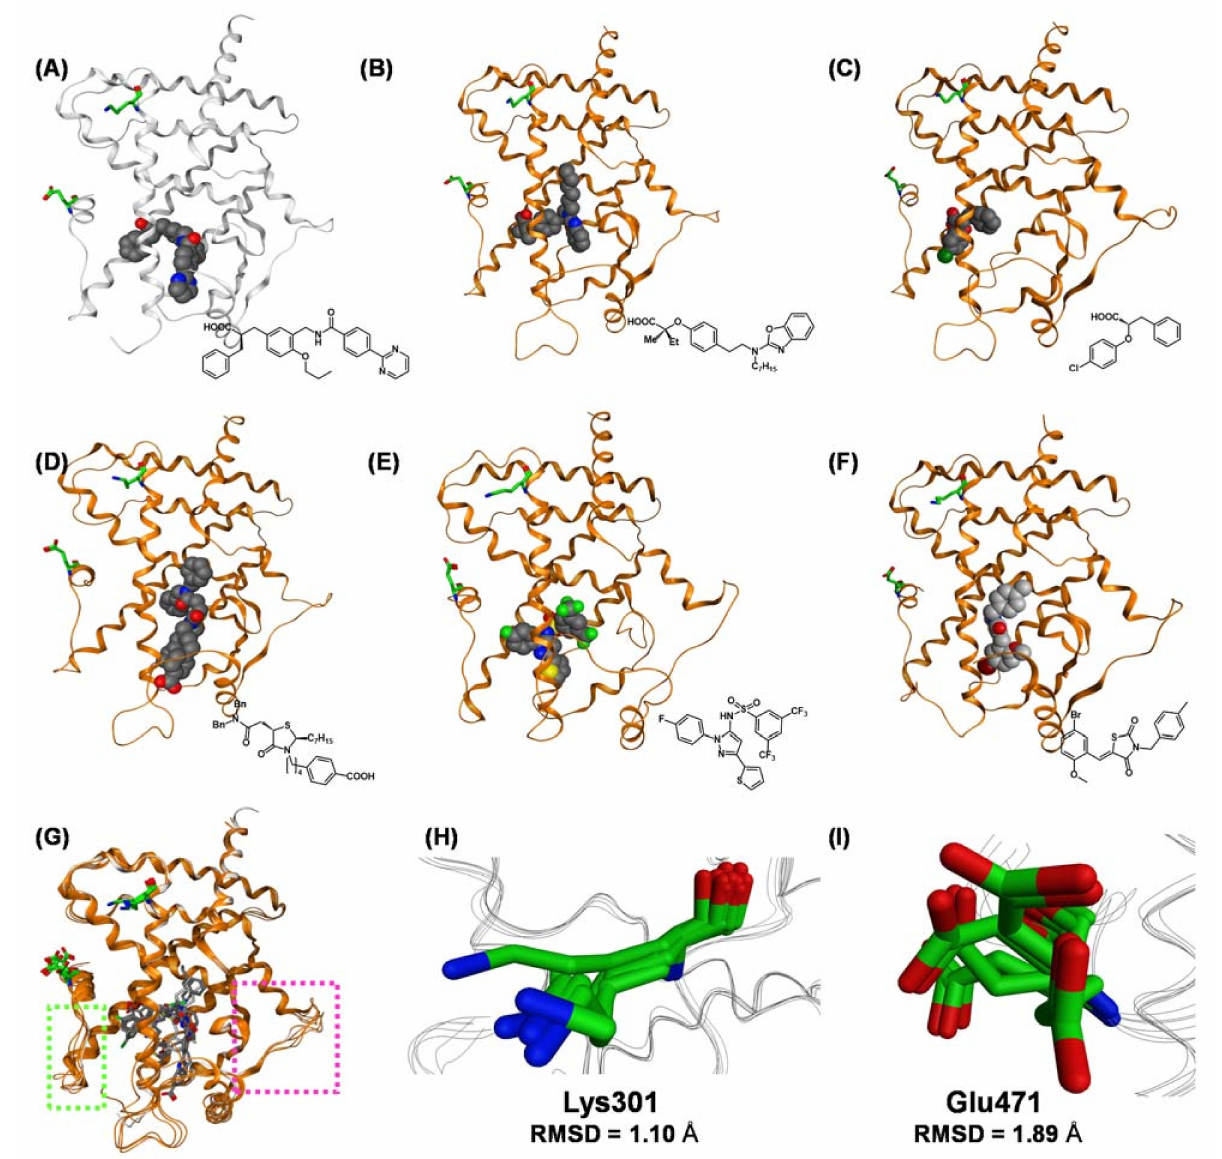
Figure 21. ( A – F ) Crystal structures of hPPAR γ LBD–partial agonist complexes. ( A ) Crystal structure of the hPPAR γ LBD– MEKT-21 complex (PDB: 3VSO). ( B ) Crystal structure of the hPPAR γ LBD–LT127 complex (PDB: 2I4Z). ( C ) Crystal structure of the hPPAR γ LBD–(2S)-2-(4-chlorophenoxy)-3-phenylpropanoic acid complex (PDB: 3CDP). ( D ) Crystal structure of the hPPAR γ LBD–GW-0072 complex (PDB: 4PRG). ( E ) Crystal structure of the hPPAR γ LBD– N -[1-(4-fluorophenyl)-3-(2-thenyl)- 1H-pyrazole-5-yl]-3,5-bis(trifluoromethyl)benzenesulfonamide complex (PDB: 2GOH). ( F ) Crystal structure of the hPPAR γ LBD–GQ-16 complex (PDB: 3T03). ( G ) The superimposed structures of hPPAR γ LBD–partial agonist complexes. All ligands are depicted as cylinder models, and Lys301 and Glu471 are highlighted as green cylinder models. The N -terminal AF2 region (H12 helix) is highlighted with a light green dotted box. ( H ) Zoomed view of the superimposed Lys301 of hPPAR γ LBD–partial agonist complexes. ( I ) Zoomed view of the superimposed Glu471 of hPPAR γ LBD–partial agonist